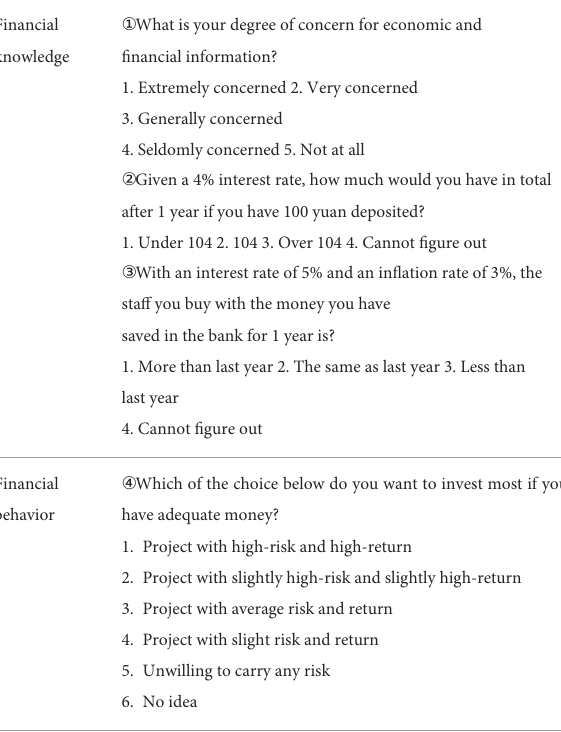
TABLE 2 The questions about financial knowledge and financial behavior to examine the financial literacy of the respondents. Dimensions Questions